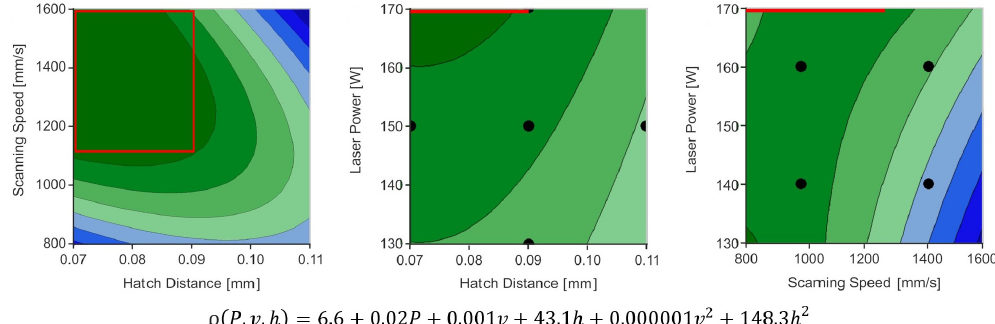
simplification of the actual correlations. Therefore, it can be misleading for certain correlations like functions of third or higher order, jump functions, progressive or degressive curves.